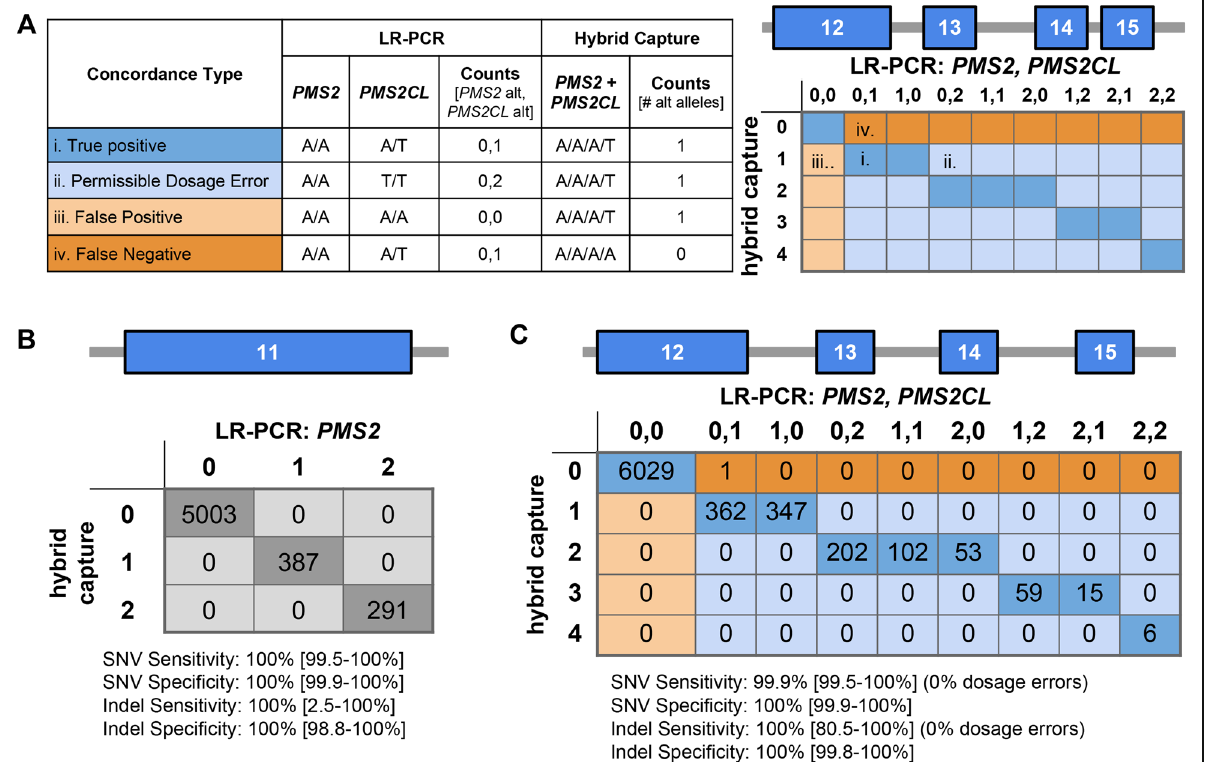
Fig. 3 Hybrid-capture and LR-PCR are concordant for SNVs and indels. a Hypothetical examples to describe the concordance table for comparison of hybrid capture and LR-PCR data. All examples assume the reference base is A and the alternate ( “ alt ” ) base is T. (i) Example of a true positive (dark blue) where an alt allele is present in PMS2CL . (ii) Example of a permissible dosage error (light blue), where PMS2CL is homozygous for the alt allele but hybrid capture only calls one alt allele instead of two. (iii) Example of a false positive (light orange), where only hybrid capture detected an alt allele. (iv) Example of a false negative (dark orange), where an alt allele in PMS2CL was missed by hybrid capture. Shaded matrix on the right indicates cells that represent true positives, permissible dosage errors, false positives, and false negatives. Numbers on axes denote the total number of alt alleles in either the hybrid capture data or the PMS2 / PMS2CL LR-PCR data. b Diploid SNV and indel concordance for exon 11 of PMS2 . Numbers on axes denote the number of alt alleles where 0 is equivalent to 0/0, 1 is equivalent to 0/1, and 2 is equivalent to 1/1. 95% confidence intervals in brackets. c Four- copy SNV and indel concordance for exons 12 – 15 of PMS2/PMS2CL , as explained in ( a